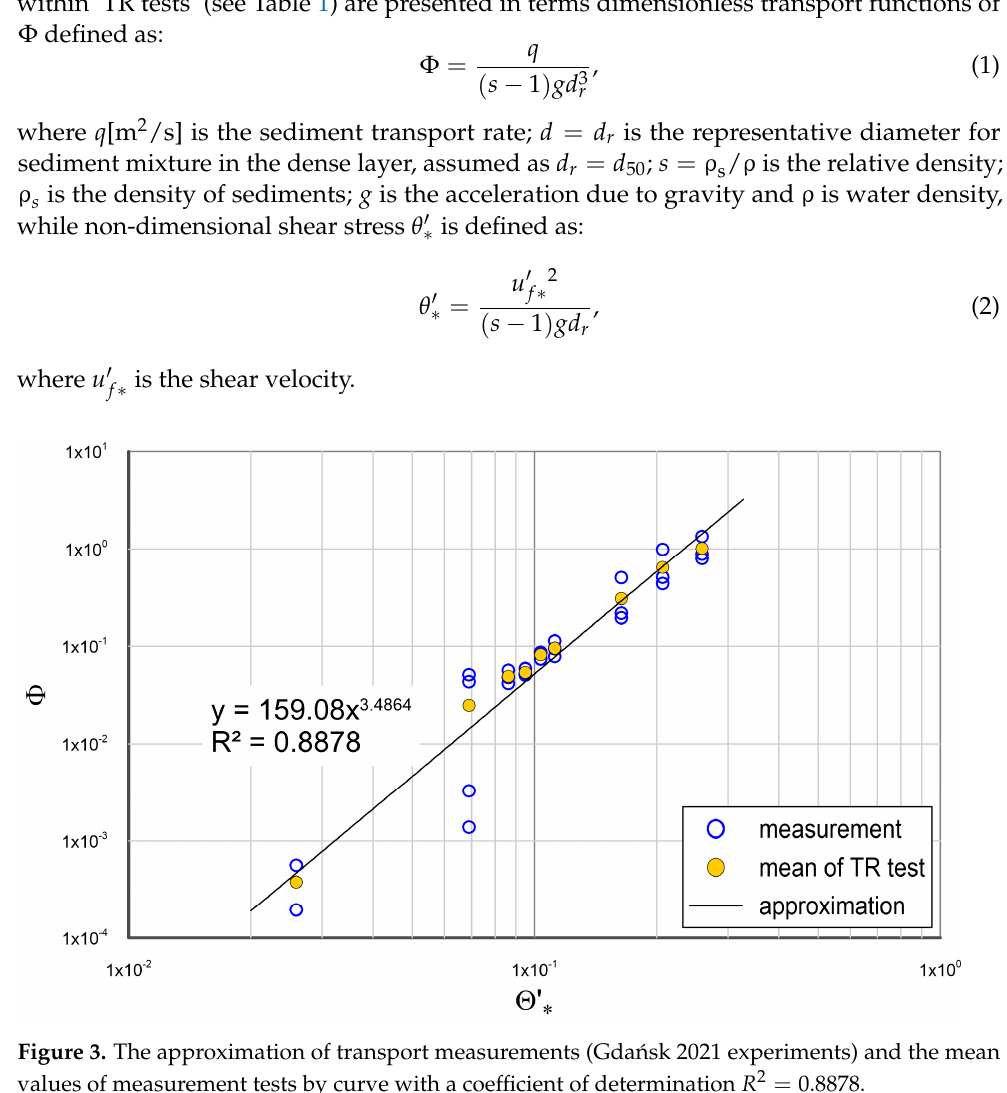
Figure 4. Grain size distribution of quartz sand in the trap at the flow ( a ) 8 l/s and ( b ) 14 l/s in the Gda ń sk 2021 experiment.